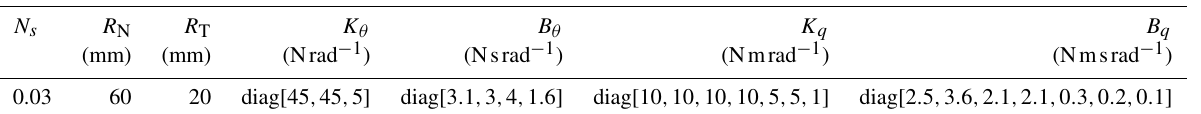
Figure 3. Overall block diagram of the force-field-based robot rehabilitation system. Table 1. Fixed parameters of the controller.